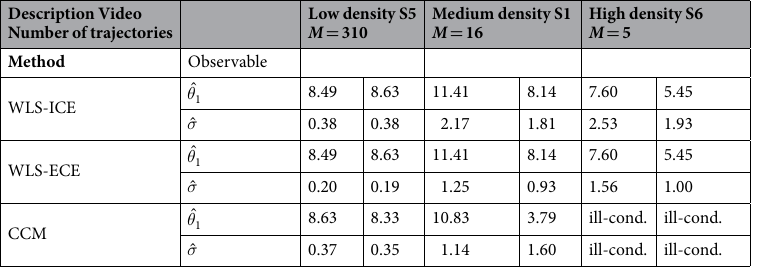
Table 1. Results of the three fitting methods for “real world” particle tracking data. Particle trajectories where extracted from the “Vesicle” Supplementary videos from the article by Chenouard et al . 48 using the “Particle Tracker” software (MOSAIC group). The trajectories where cut into shorter trajectories, all of length 7 discrete process times. The short trajectories were then divided into two independent sets of size M . We then performed fitting using the WLS-ICE, WLS-ECE and CCM methods for BM, discarding the first process time point, resulting in N = 6 sampling times. Expected parameter value is θ 1 = 8 (data are noisified and pixelized simulations with known properties). Since M was very small for video S6, we applied the jackknife procedure both in parameter and error estimation (all videos). Results before jackknifing are found in Table S1 in Supplementary Information. We notice that the CCM method gives ill-conditioness issues for the high density movie, where few trajectories could be extracted. The WLS-ECE method underestimates the error as compared to WLS-ICE